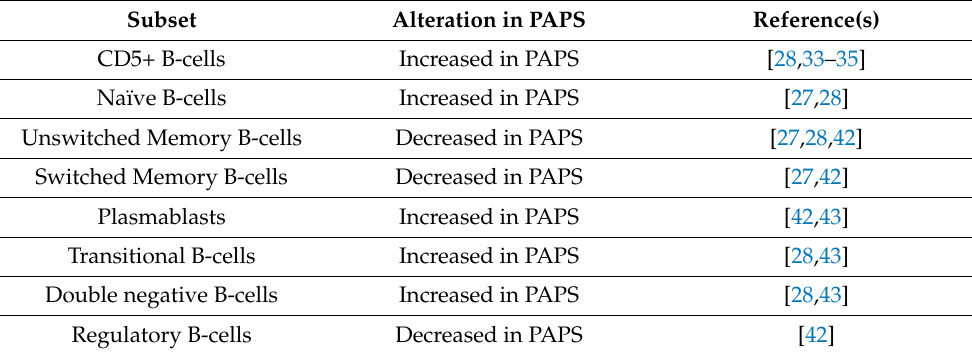
Table 1. Overview of alterations in B-cell subsets reported in